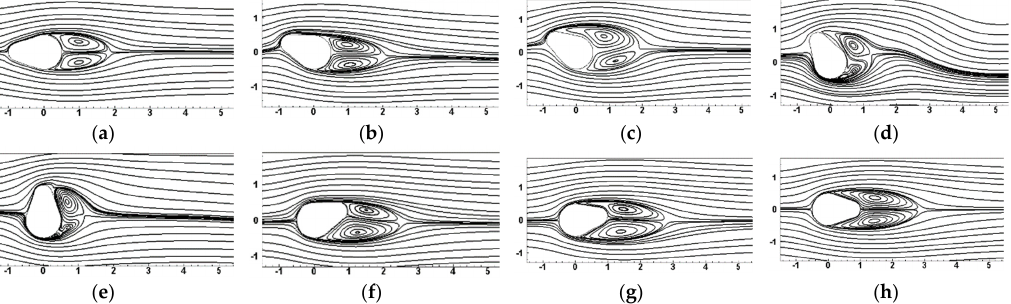
Figure 9. Time-averaged streamlines at different wind attack angles: ( a ) 0°, ( b ) 20°, ( c ) 30°, ( d ) 60°, ( e ) 90°, ( f ) 160°, ( g ) 170°, and ( h ) 180°.